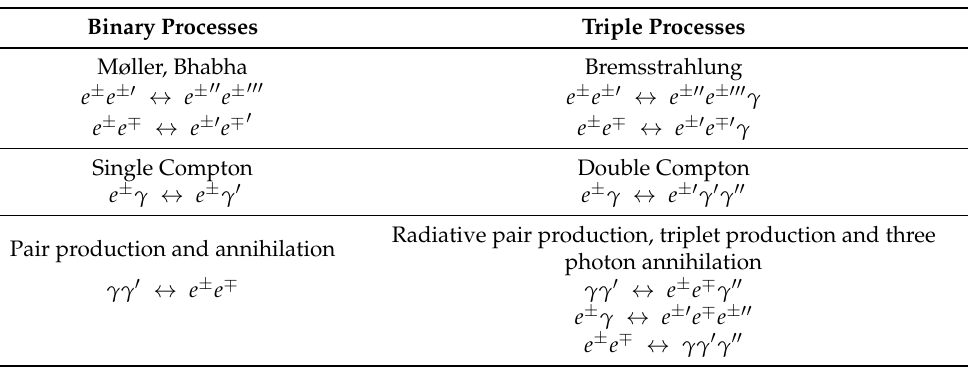
Table 1. Binary and triple QED processes in the pair plasma. Binary Processes Triple Processes Møller, Bhabha Bremsstrahlung